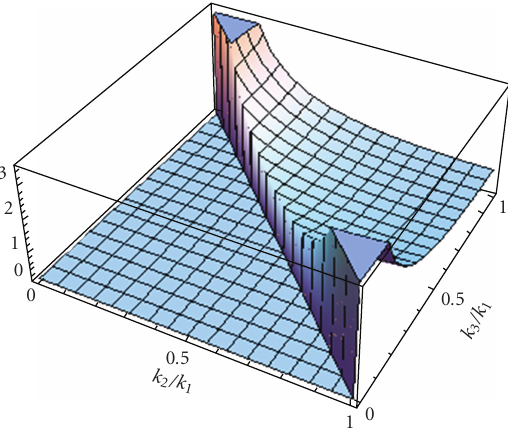
Figure 16: Shape of the local form